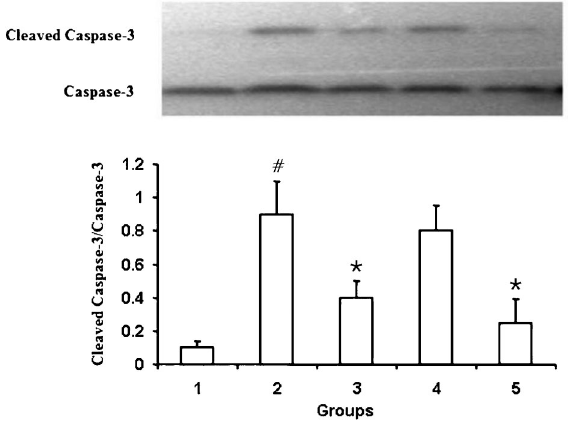
Figure 3. Ischemic preconditioning (IPC) inhibits ischemic reperfusion (I/R)-induced cleaved caspase-3 expression 24 h post-ischemic injury. Data are reported as means±SE of 4 rats in each group. Groups: 1) sham control, 2) I/R, 3) 5 6 5 6 5 min